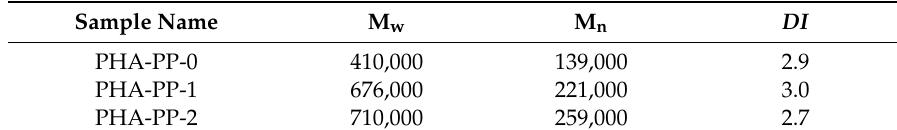
Table 4. The GPC results of the PHA-PPx samples produced after 48 h in shake flask analysis with PP-0 to 2 as additional carbon sources.